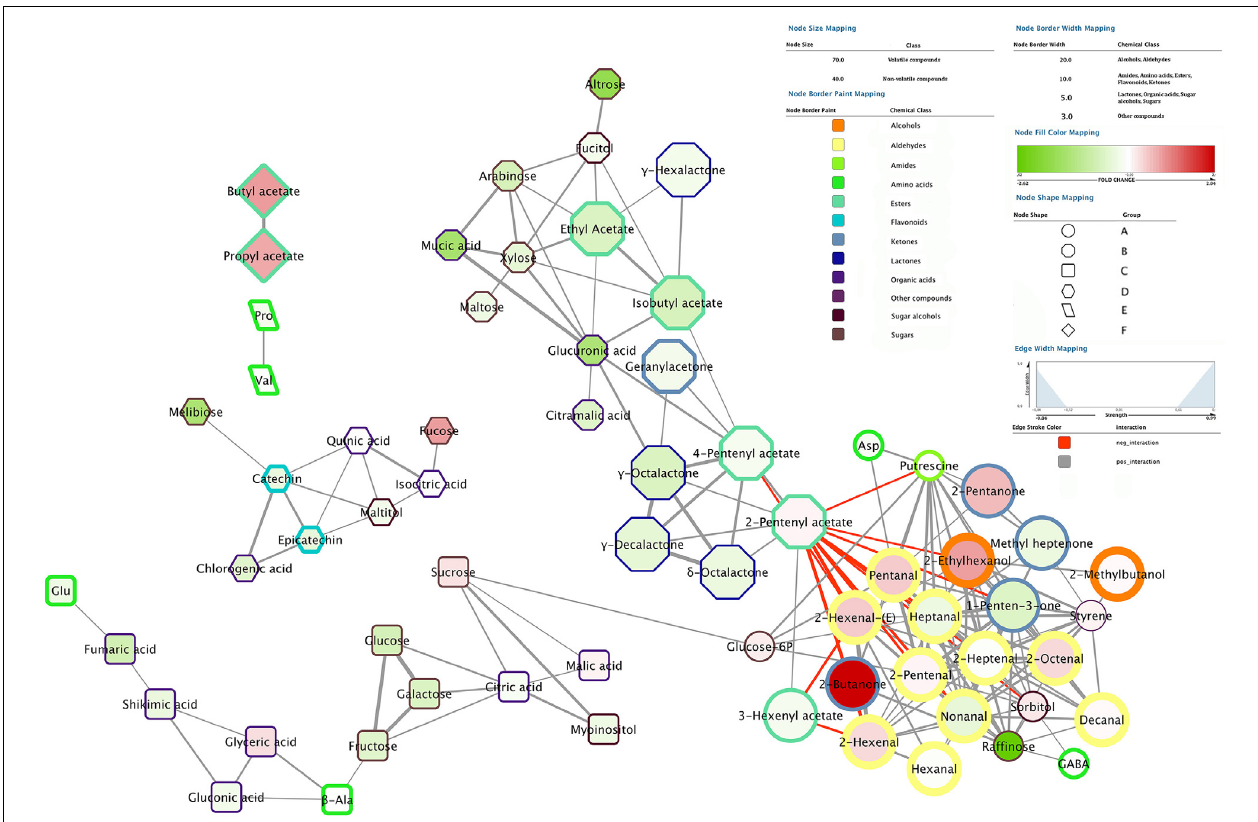
FIGURE 7 | Correlation network analysis performed employing 0.7 as correlation coefficient cut-off. Nodes represent detected molecules showing significant positive or negative interaction between each other. Volatile compounds are reported with nodes of larger size compared to non-volatile nodes. Different node border color, from yellow to brown, and width are used to depict the different chemical classes. Nodes are filled with colors ranging from intense green to dark red which represent the fold change level of each compounds when comparing chilling injured (cold stored fruit, both low temperatures, +SL) vs. sound (control) fruit after 2 weeks of storage. Positive values (compounds more abundant in chilling injured peaches) are reported in red while negative values (compounds more abundant in sound peaches) are depicted in green. Different node shapes are used to depict different groups of compounds: circles, octagons, squares, hexagons, parallelograms, and diamonds represent group A, B, C, D, E, and F, respectively. Groups A, B, and C are linked together in the network while groups D, E, and F are separated from each other. Gray and red edges represent positive and negative interactions, respectively, whereas edge thickness is directly related with the strength of the interaction: the larger the thickness the stronger the